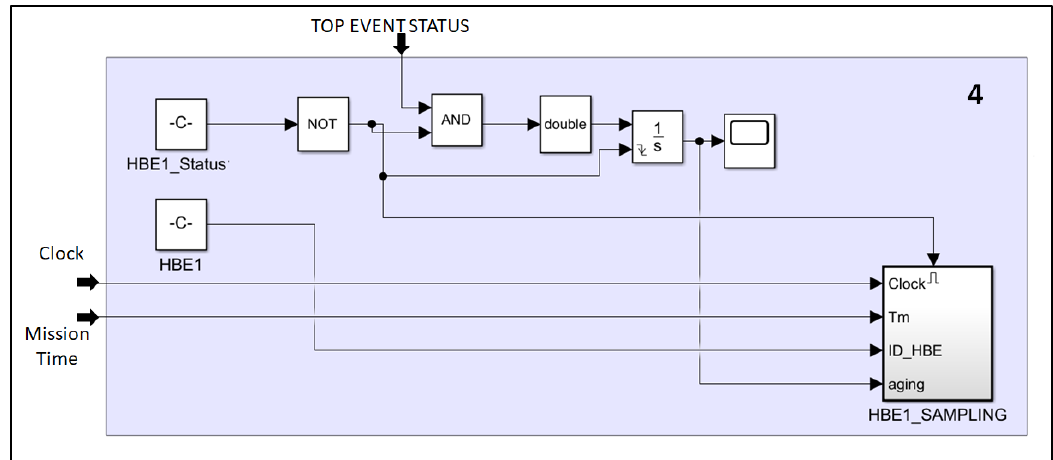
Figure 4. Simulink model of the HBE1 and HBE5 of the case study.